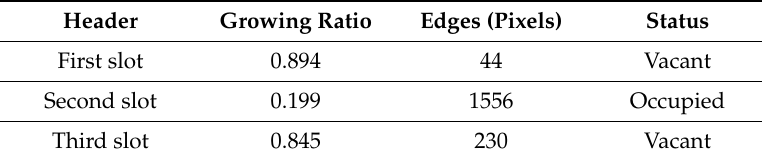
Table 2. Parking space features at Guang Hua Digital Plaza.